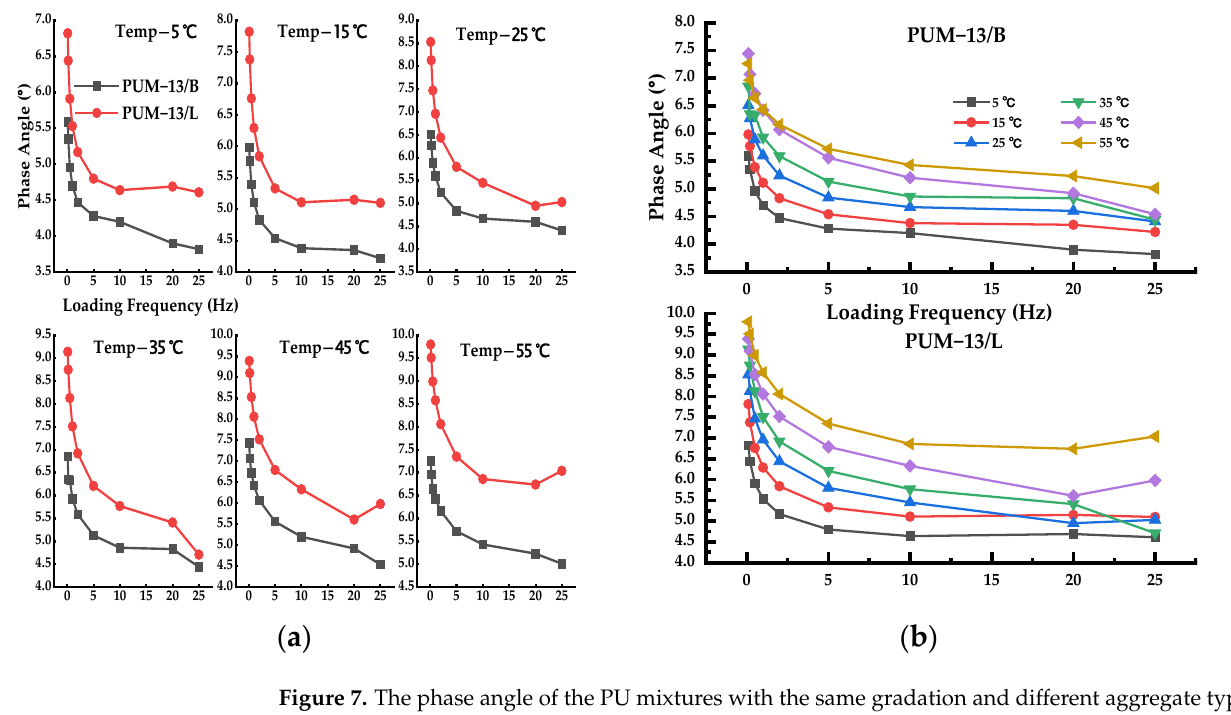
Figure 7. The phase angle of the PU mixtures with the same gradation and different aggregate types. ( a ) phase angle under different test temperatures, ( b ) phase angle with different aggregate types. 3.5. The Effect of the PU Type on the Dynamic Modulus and Phase Angle The dynamic modulus and phase angle results of the PU mixture with the same gradation and different PU types at different test temperatures and loading frequencies are plotted in Figures 8 and 9.